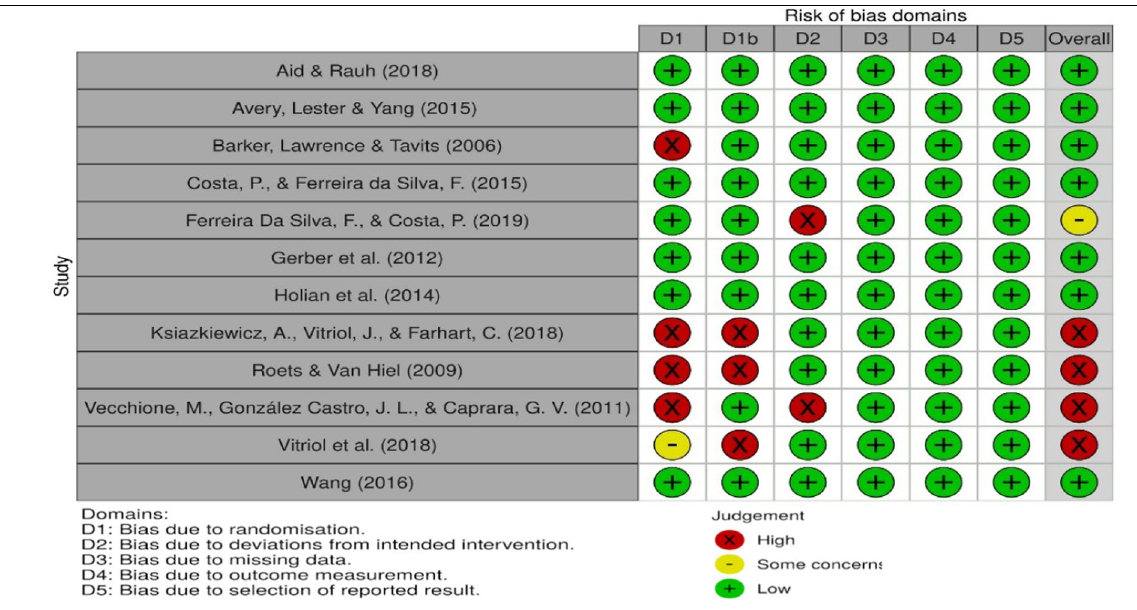
Table 2 RoB table and RoB ratings for the included